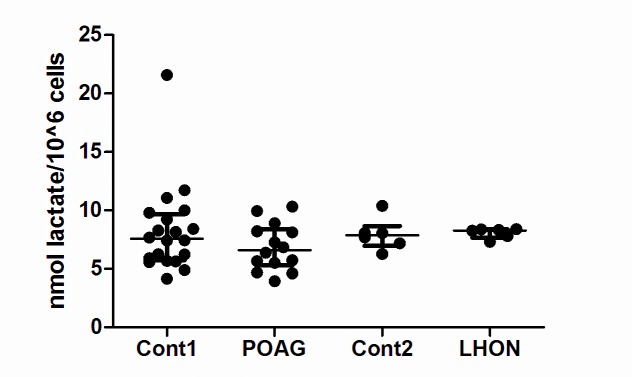
No changes in cellular lactate production in POAG or LHON lymphoblasts.Lymphoblasts were incubated in high glucose media (RPMI supplemented with glucose increased to 4mg/ml from the standard RPMI level of 2, uridine at 50 μg/ml, pyruvate at 1mM + 15% heat-inactivated FCS) for 48 hours prior to lymphoblast media supernatant being harvested for lactate measurement. There was no significant difference in extracellular lactate levels (reflective of cellular lactate production) between POAG lymphoblasts and controls, or between LHON lymphoblasts and controls. Data is median (IQR), n = 20 cont1, n = 15 POAG, n = 6 cont2 and n = 6 LHON.